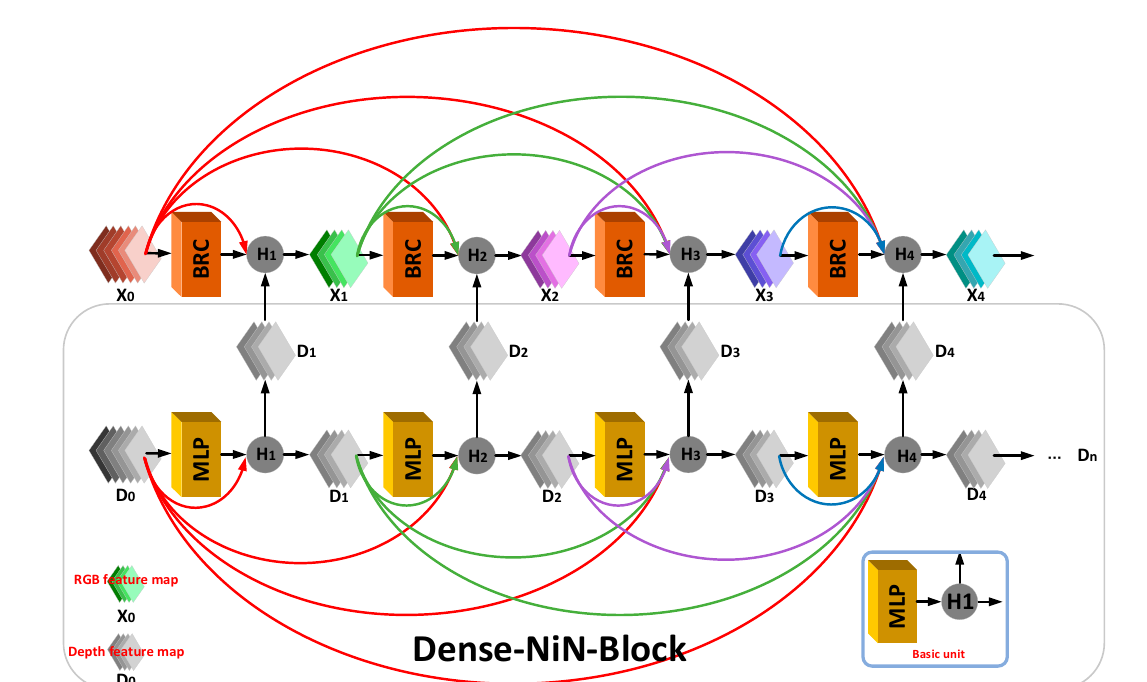
Figure 7. Dense-NiN-Block structure sends the feature extraction map to the process representation of Dense-Block structure. In this picture, the contents of the boxes indicates the Dense-NiN-Block structure. X n indicates the feature map output by each convolutional layer in the RGB stream. D n indicates the feature map output by each layer of convolution in the depth stream. H n represents the feature map fusion layer.